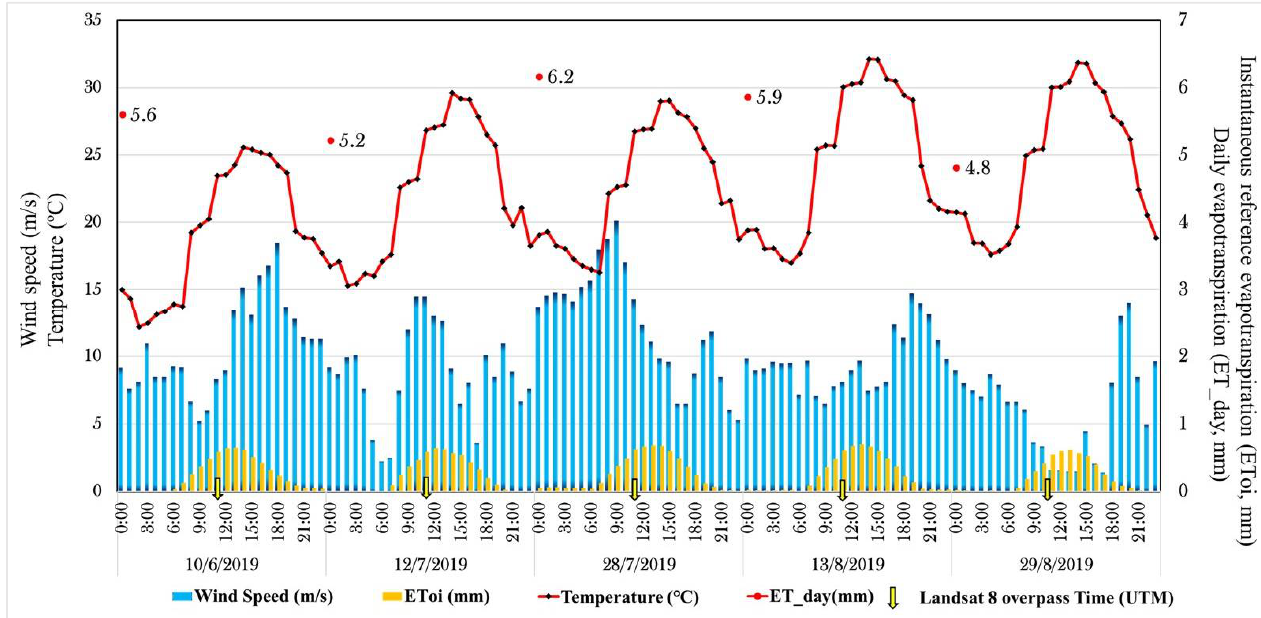
Figure 2. Meteorological condition during the study time satellite overpass in the study area (Xinjiang, local time).